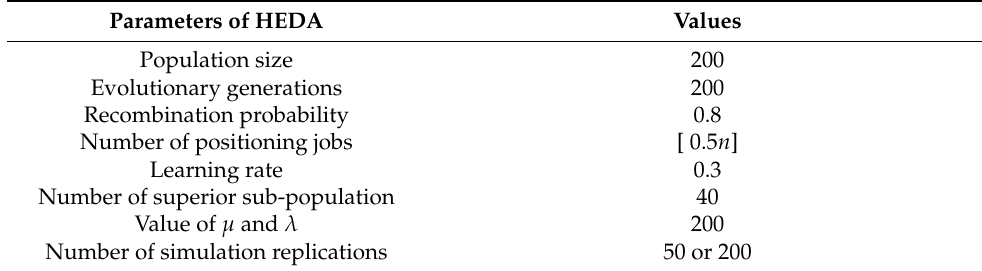
Table 2. The parameters setting for